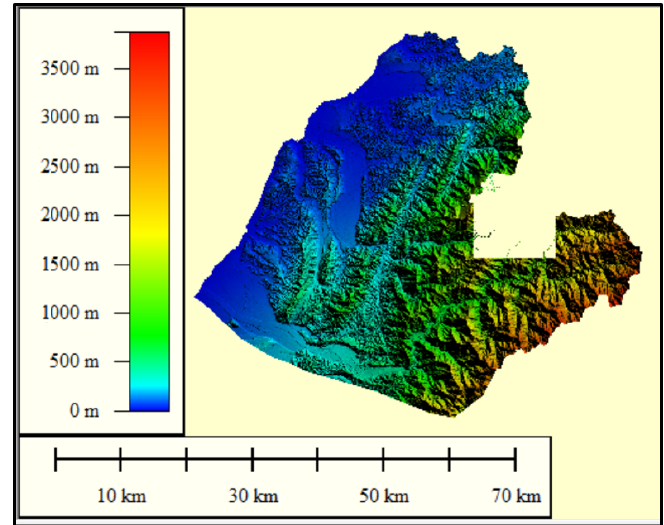
Figure 6. The DEM of Miaoli County.